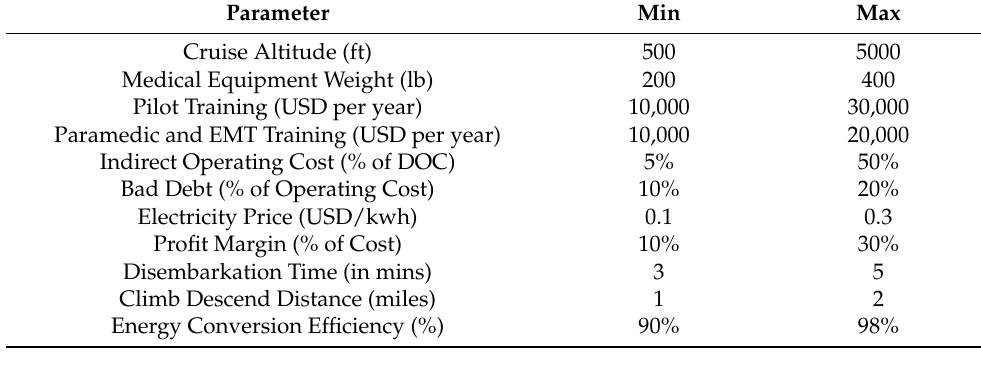
Table 5. Monte Carlo simulation assumptions.